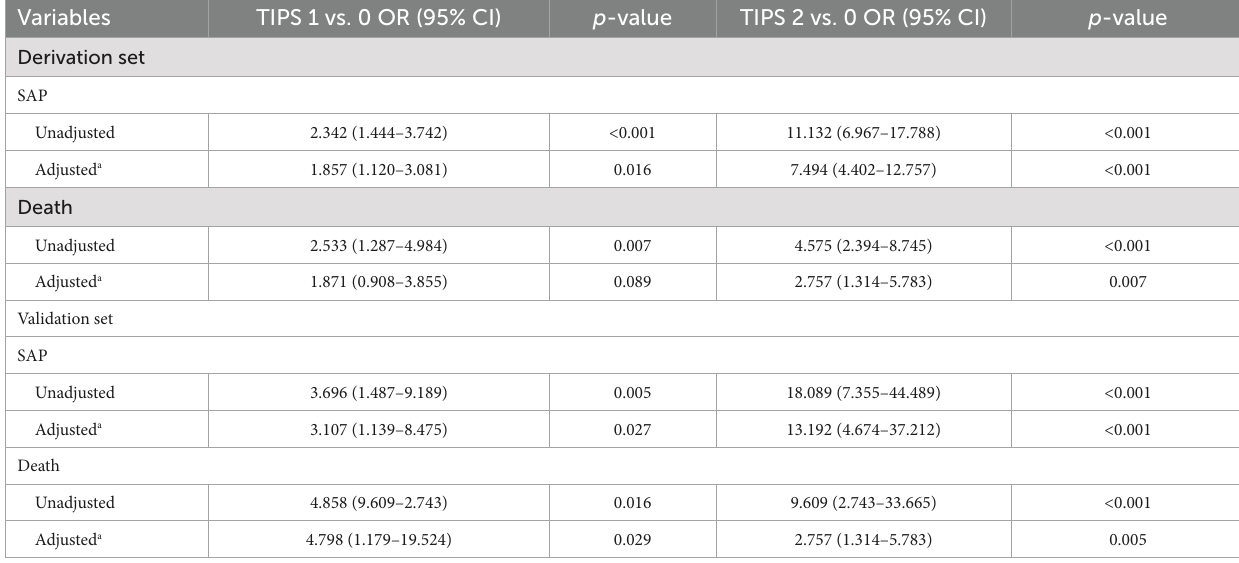
TABLE 2 Logistic regression analysis regarding correlations between TIPS and clinical outcomes in both the derivation set and the validation set.